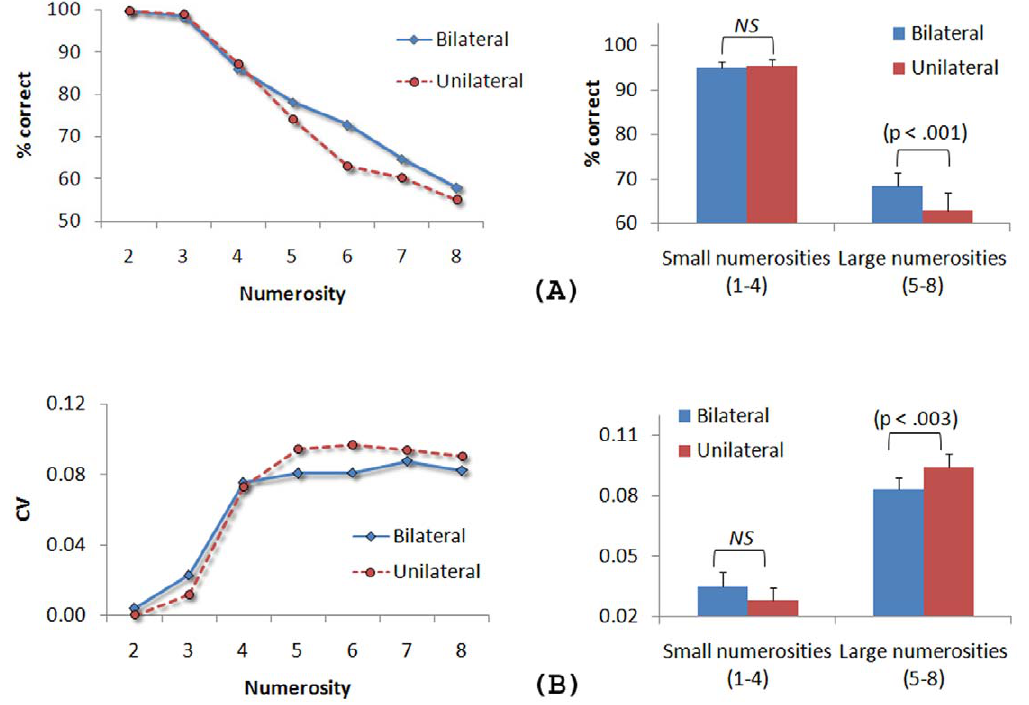
Figure 2. The results of Experiment 1. (A) Percentage of correct responses and coefficients of variation as a function of condition and numerosity. (B) Averaged percentage of correct responses and coefficients of variation divided across small and large numerosities. The p value is shown when the difference between the bilateral and unilateral conditions is significant. ‘NS’ (i.e., ‘non significant’) is shown when the difference is not significant. The error bars represent 6 1 standard error of the mean. No error bars are shown in (A) to preserve the readability of the data.